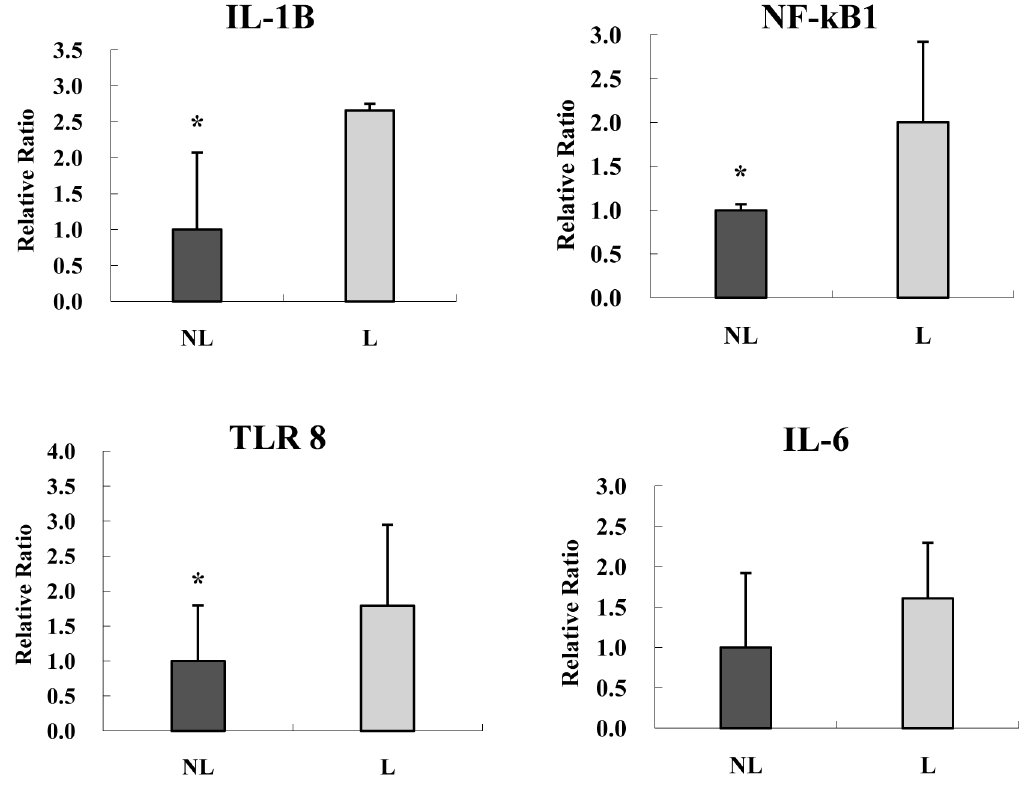
Figure 4. Real-time RT-PCR results for genes associated with inflammation. Real-time RT-PCR results for genes associated with inflammation in the trophoblast layer of labor placenta. The data are reported as means ± SD with significant differences between the non-labor group and the labor group labeled with asterisks (*, p <0.05) NL and L represent the non-labor and labor group, respectively (n=6). doi: